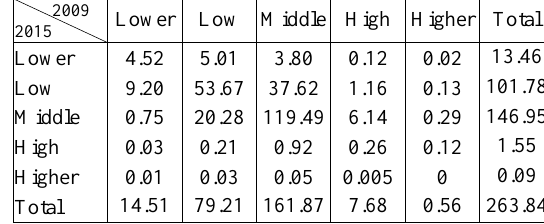
Table 5. The transfer matrix of soil area with different moisture levels from 2009 to 2015 (area/km 2 )